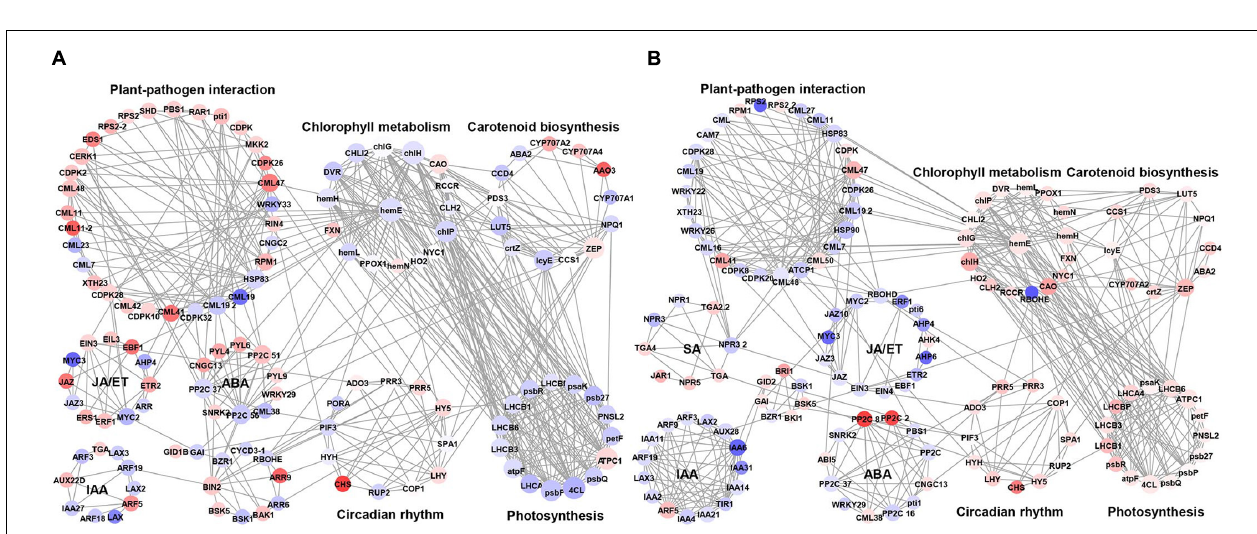
FIGURE 7 | Protein-protein interaction network for the DEGs of defense-related pathways in P. pyrifolia at NS after infection by each C. fructicola strain. (A,B) The network constructed for strain PAFQ31 and PAFQ32, respectively. Red and purple indicate up-and downregulated gene expression, respectively.